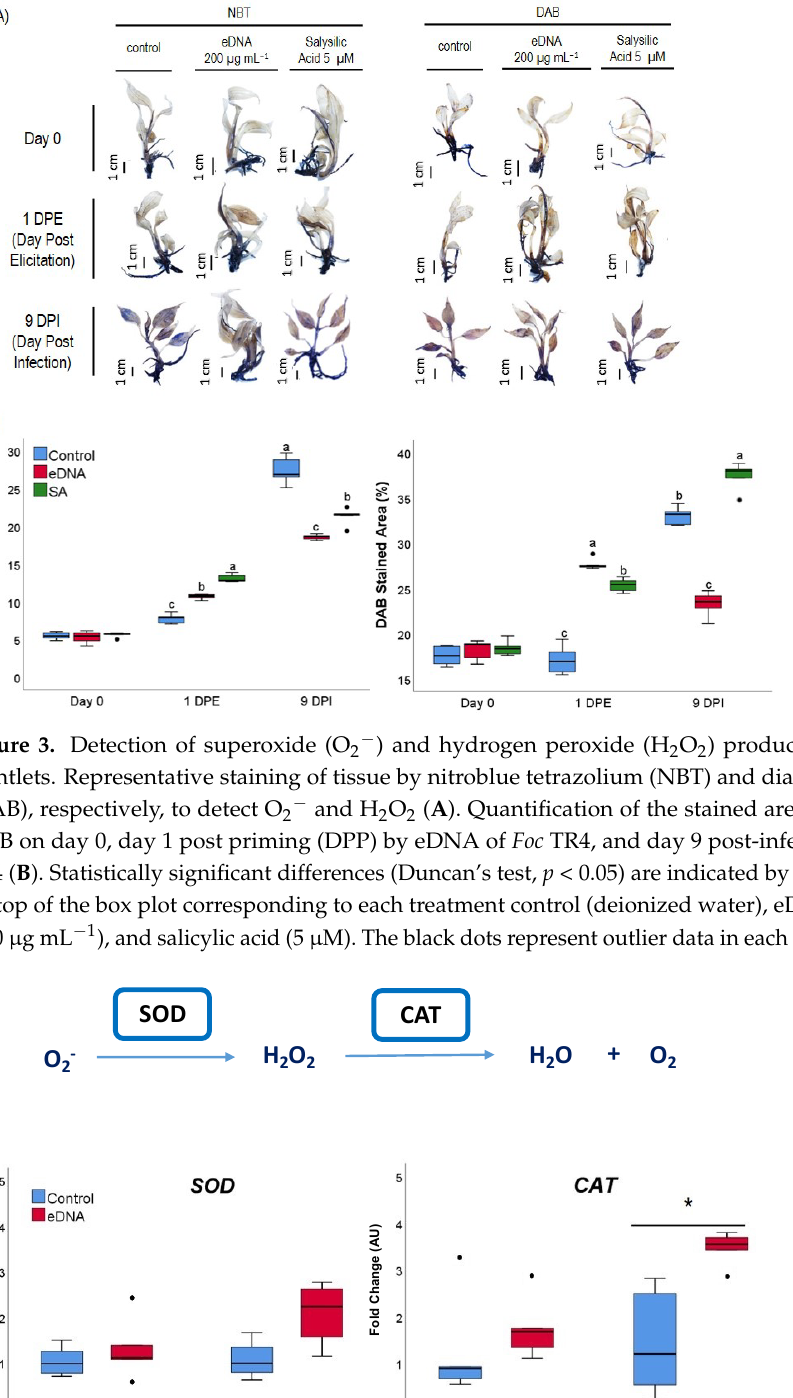
Figure 4. Effect of eDNA treatment from Foc TR4 on banana cv. Cavendish resistance to Foc TR4 infection by examining SOD and CAT gene relative expression: ( A ) SOD catalyzes the dismutation of O 2 − into H 2 O 2 molecules and subsequently CAT will catalyze the breaking up of H 2 O 2 into water and oxygen. ( B ) Relative expression of SOD and CAT genes to the GAPDH gene on 0 and 9 DPI by Foc TR4. The asterisk represents a significantly different value based on an independent t -test, comparing the two groups of treatment. The black dots represent outlier data in each sampling point.